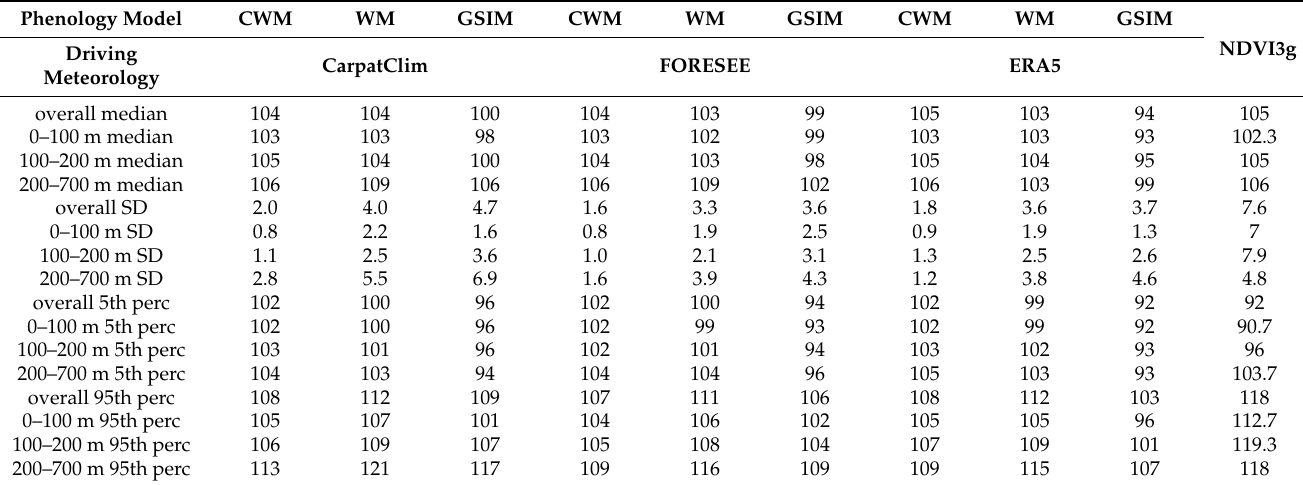
Table 2 provides key statistics behind the SOS climatology maps, allowing for quan- titative insight into the spatial variability of the SOS estimates. The observation-based median SOS date for the 1982–2010 period is DOY 105 (15 April). SOS values increase with elevation both according to the models and the observation (with the exception of FORESEE-driven GSIM and ERA5-driven WM). Model–database combinations typically reproduce the observed median given the optimisation of the models. GSIM systematically predicts earlier SOS relative to the observation, except for the CarpatClim input data in the 200–700 m elevation class. In the case of CWM and WM, the different meteorological datasets provide very similar results. Table 2. Spatial statistics of the SOS climatologies (expressed by DOY): Medians, standard deviations, 5th and 95th percentiles. Percentiles are abbreviated as “perc”, standard deviation is abbreviated as “SD”. The last column presents the observation-based data. Results are presented for the selected elevation classes as